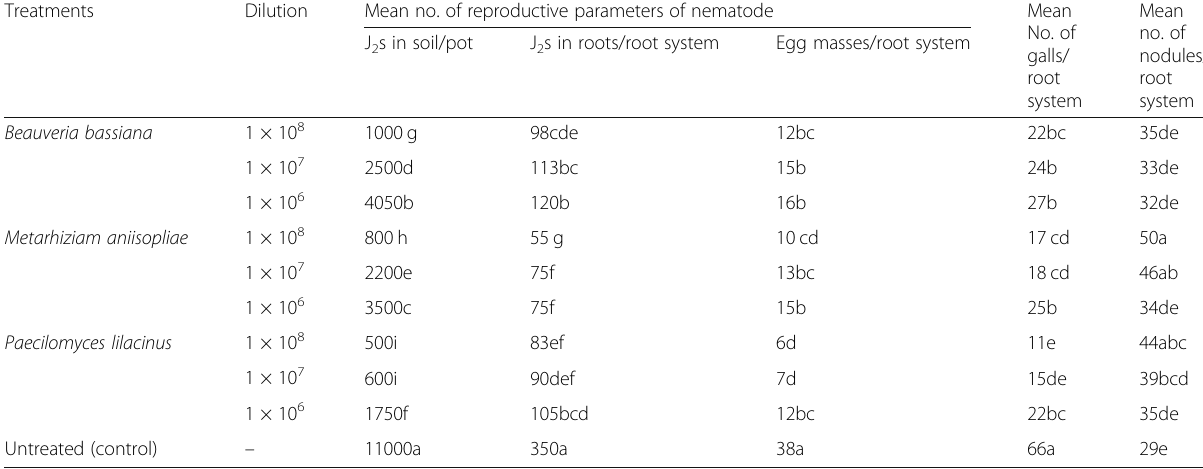
Table 6 Number of root-knot nematode, Meloidogyne incognita infecting cowpea, number of galls and number of nodules as affected by three spore concentrations from Beauveria bassiana , Metarhiziam aniisopliae , and Paecilomyces lilacinus Treatments Dilution Mean no. of reproductive parameters of nematode Mean